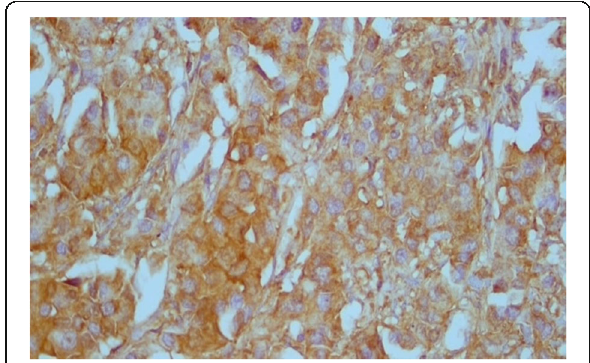
Fig. 2 Moderate RRM2 expression in cancer breast ×